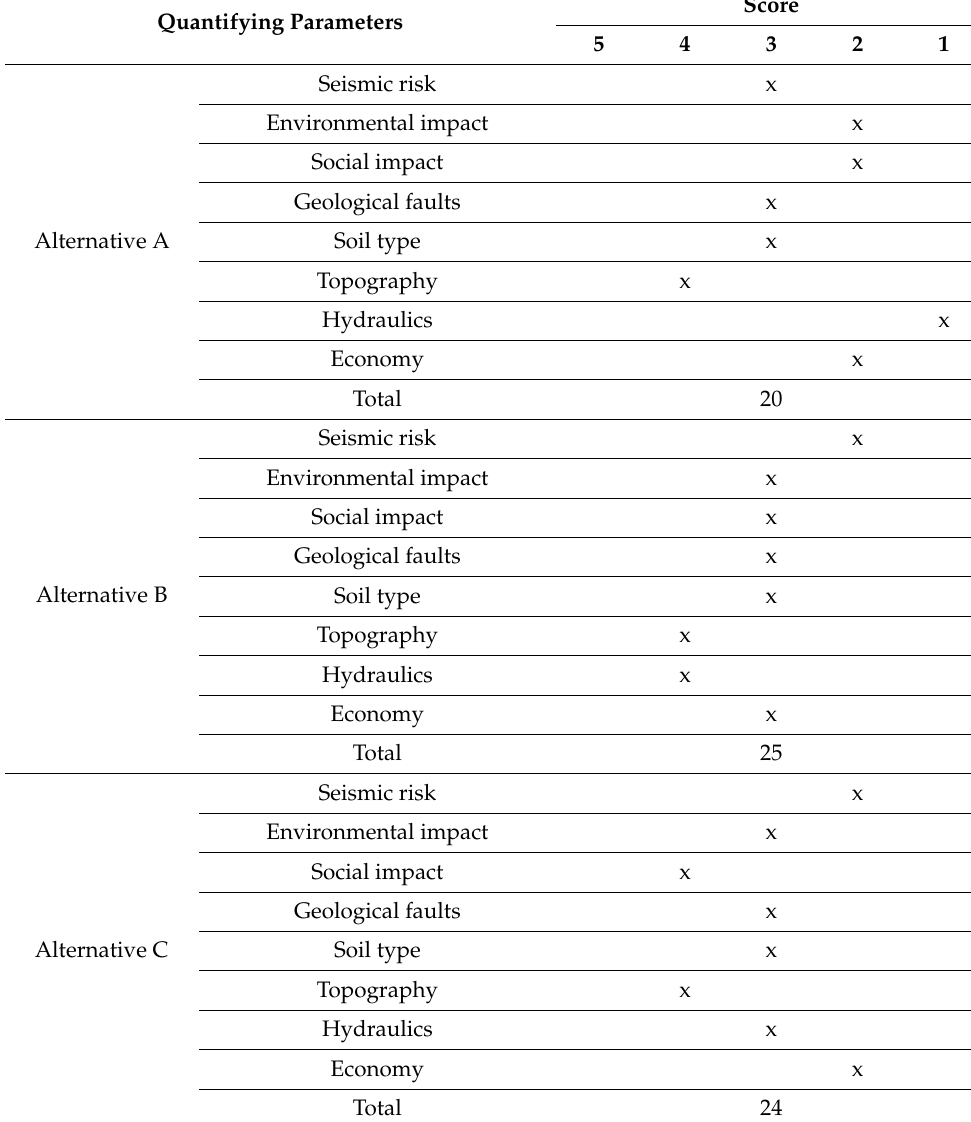
Table 5. Results of the assessment using the Likert scale for alternatives A, B, and C.